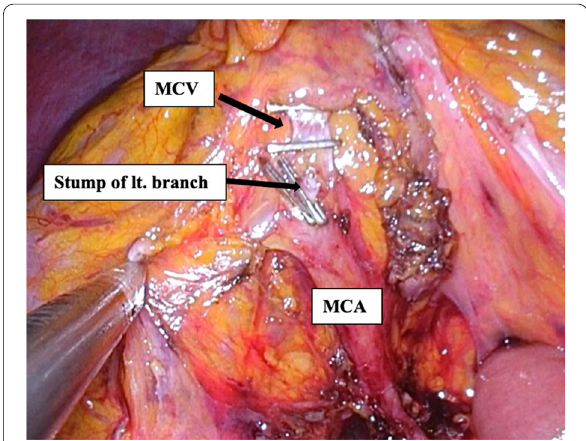
Fig. 3 Intraoperative findings. The left arterial branch of MCA was dissected at bifurcation and MCV was dissected at the same level after the lymph node